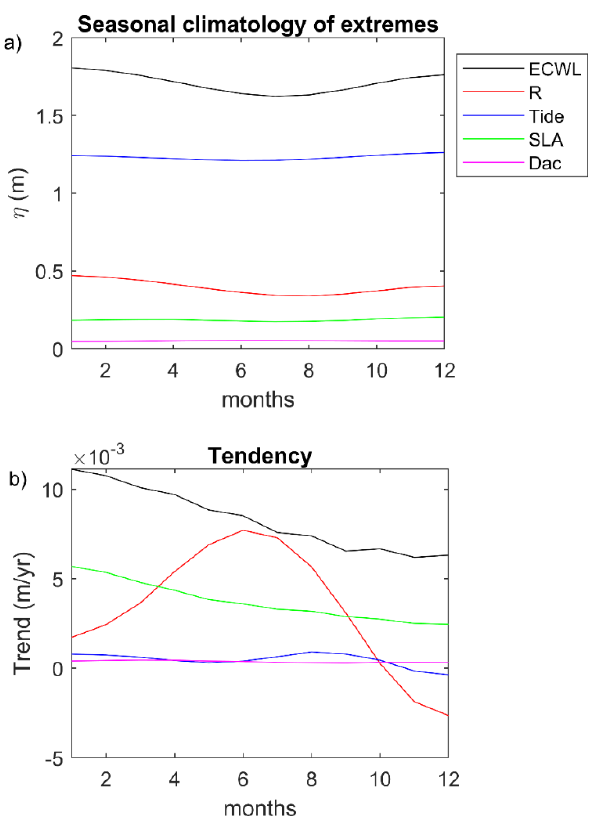
Figure 5. Trend of increasing ECWL values due to South Atlantic swells. ( a ): the analysis of the results of the seasonality of the components of ECWL; ( b ): the analysis of the results of